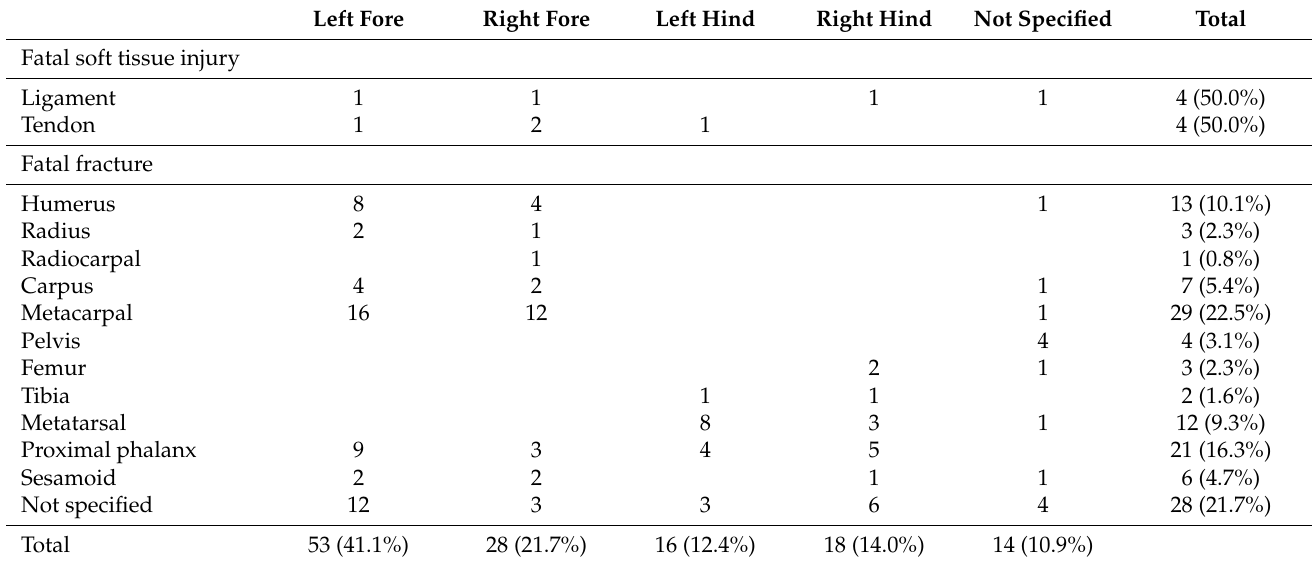
Table 3. Anatomical site identified with fatal soft tissue injury and fatal fractures associated with a race day fatalities in Thoroughbred flat racing from 2011/12–2021/22 racing seasons.